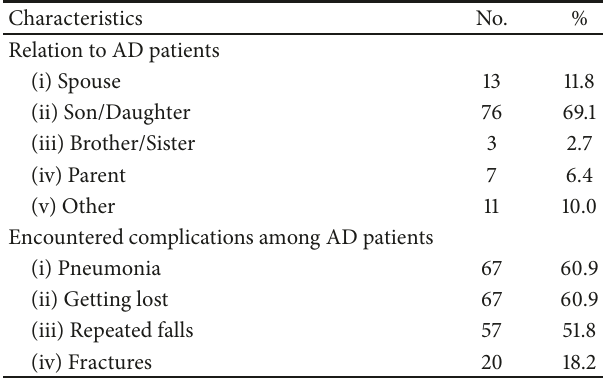
Table 2: Characteristics of AD patients as stated by